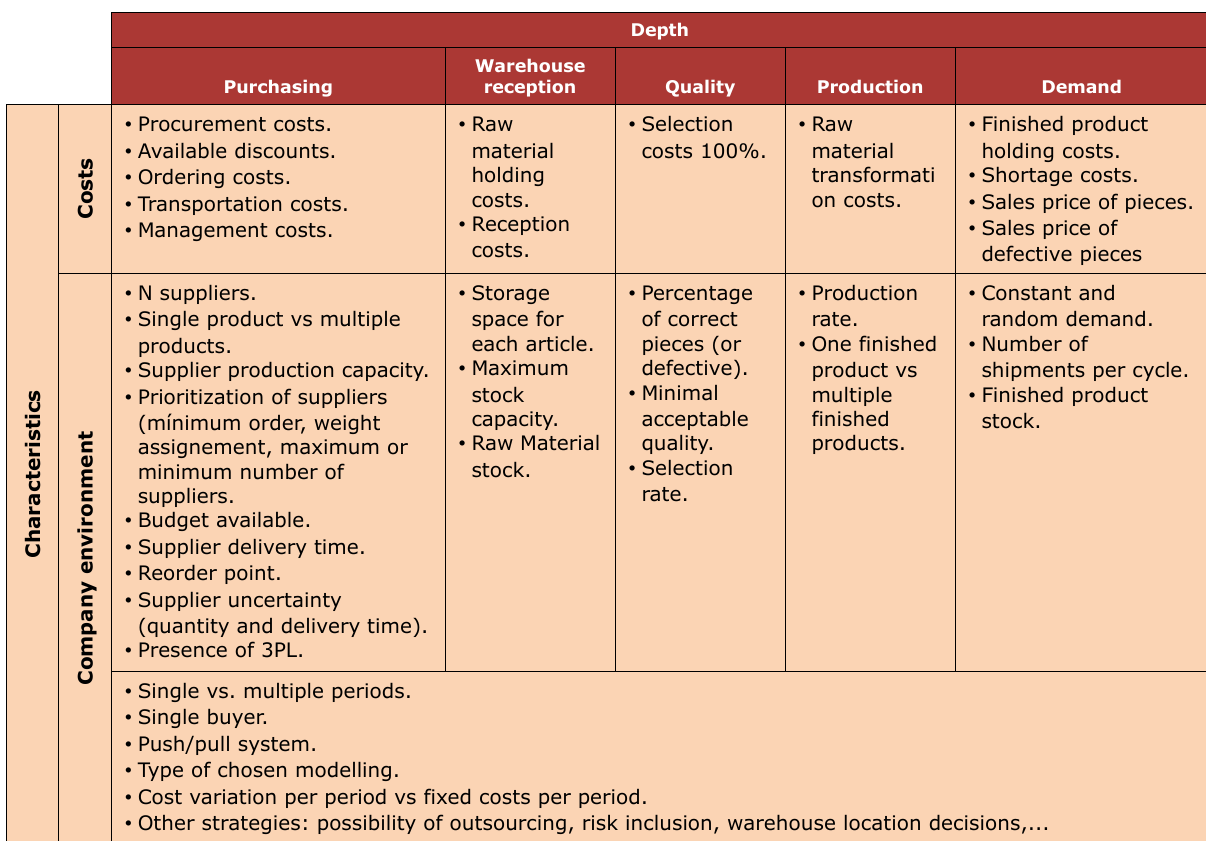
Table 1. Description of axes (depth and characteristics) determining model